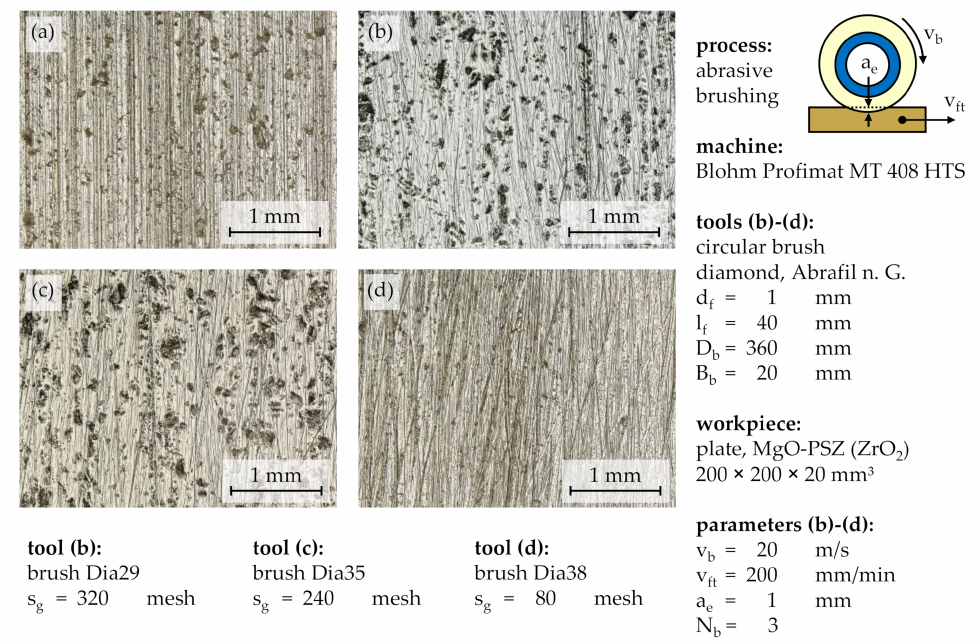
Figure 6. Light microscopy images of ZrO 2 under the variation of the grain size s g : ( a ) ground surface; ( b ) brushed with a grain size of s g = 320 mesh; ( c ) brushed with a grain size of s g = 240 mesh; ( d ) brushed with a grain size of s g = 80 mesh.